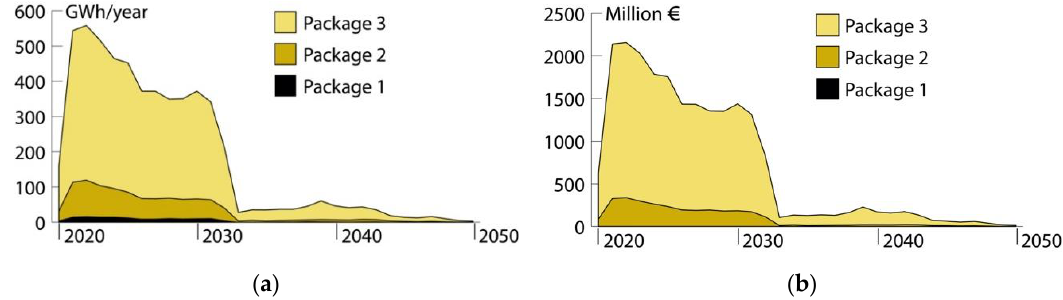
Figure 9. The figure shows yearly, cumulative: ( a ) Energy savings potential from the different energy retrofitting packages and ( b ) The associated costs. The results are based on the energy retrofitting strategy presented in Figure 7 and the referred energy retrofitting packages [44]. This figure is based on the assumption that 50% of buildings not suitable for additional façade insulation are allocated Package 3, and that buildings are refurbished and energy retrofitted when they reach their expected service life of 50 years. The expected service life has been adjusted based on previous refurbishments, and pent-upped needs for refurbishment have been evenly distributed between year 2020 and